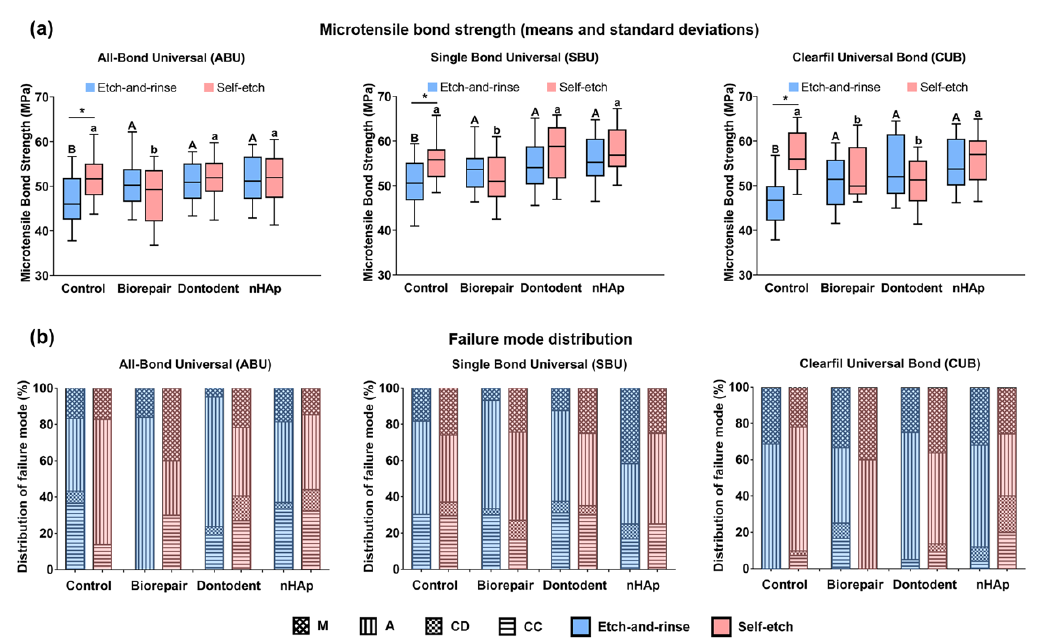
Figure 2. Micro-tensile bond strength and failure mode. ( a ) Effects of desensitizer types and bonding modes on bond strength of universal adhesives. Different superscript uppercase letters indicate significant differences with etch-and-rinse mode ( p < 0.05). Different superscript lowercase letters indicate significant differences with self-etch mode ( p < 0.05). * denotes a significant difference between the etch-and-rinse mode and self-etch mode ( p < 0.05). ( b ) Failure mode distribution of fracture specimens. M: mixed failure; A: adhesive failure; CD: cohesive failure within the dentin; and CC: cohesive failure within the composite resin.